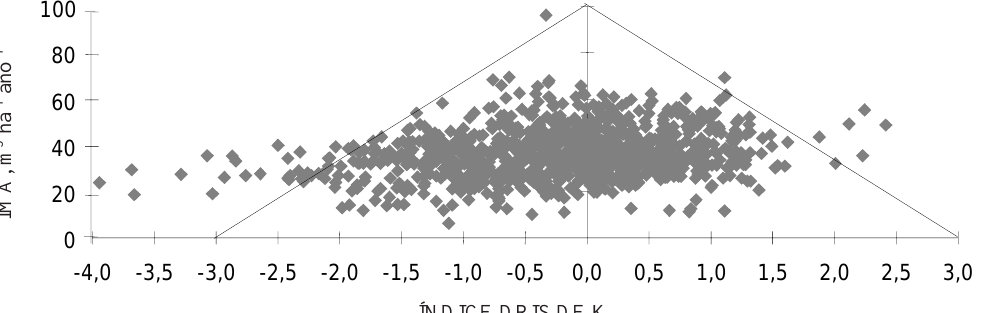
eucalipto.Figura 2. Gráfico de dispersão entre o incremento médio anual do lenho (IMA) em relação ao índice DRIS de K nas folhas de 1.213 de árvores adultas de